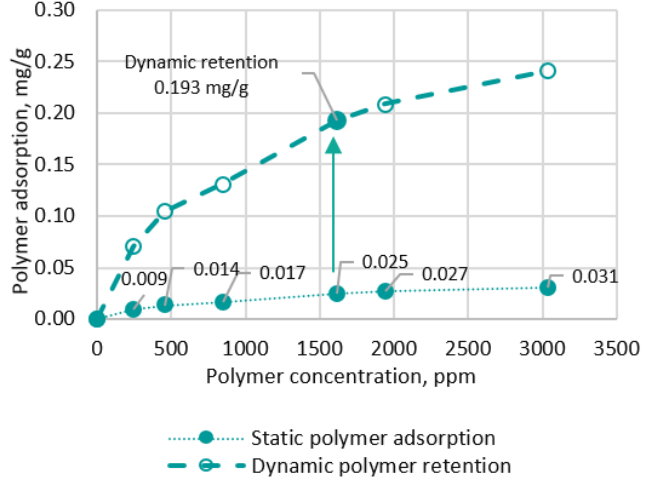
Figure 7. Curve of adsorption dependence on polymer concentration.